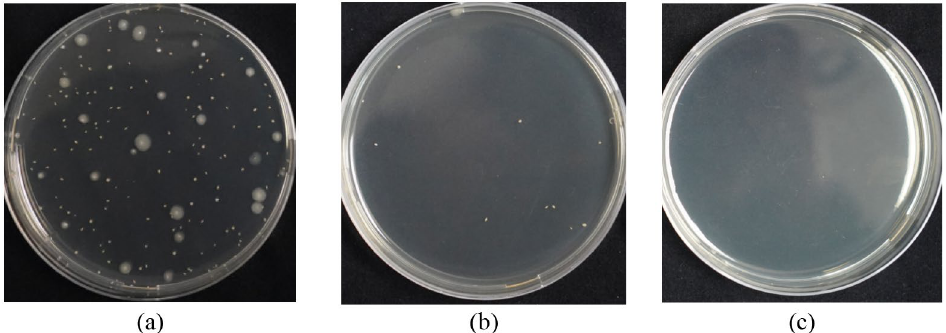
Figure 3. Counted live E. coli under an irradiation dose of 1 mJ/cm 2 with the pouring plate method: ( a ) the sample with the inoculated E. coli before far-UVC irradiation; ( b ) the sample with the inoculated E. coli after irradiation; ( c ) the sample without inoculation.